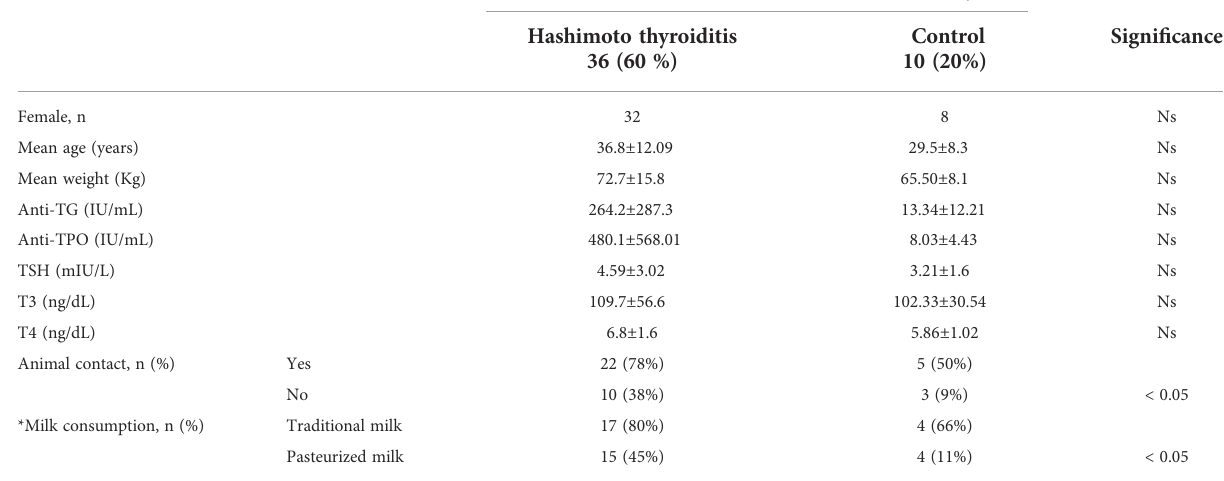
TABLE 4 Statistical results of demographical and laboratory tests data among MAP positive in the patients and control group. Variable